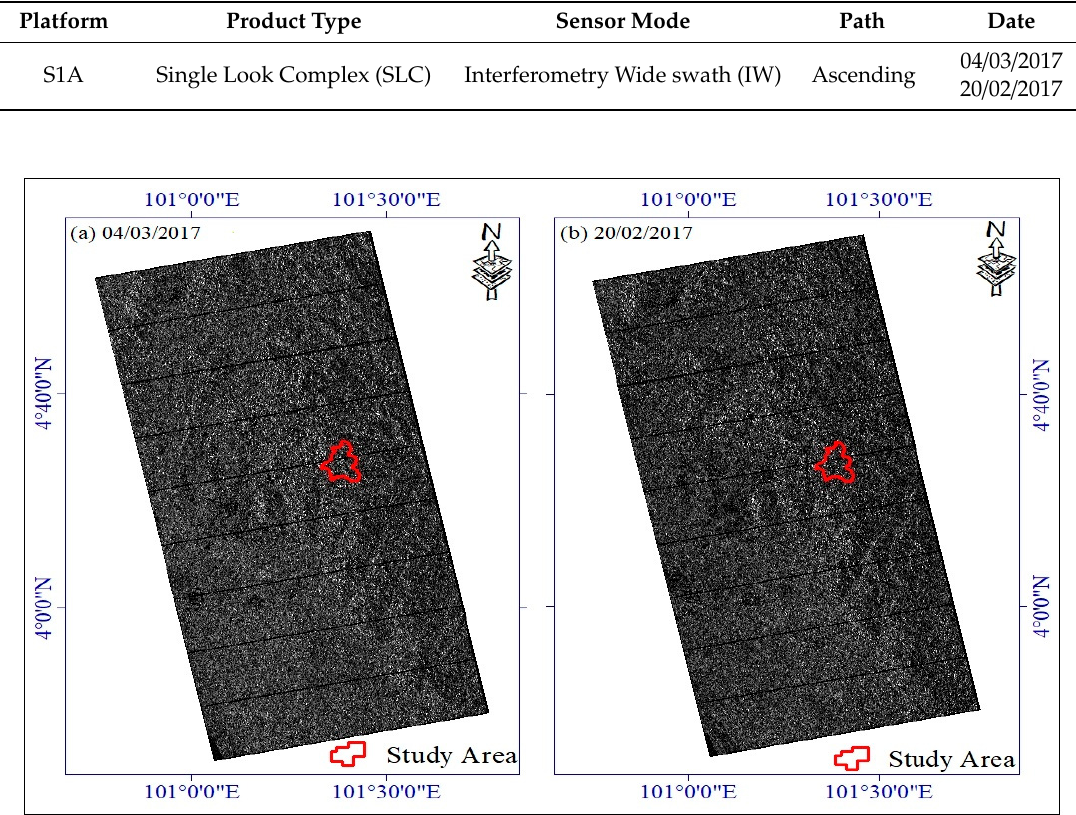
Figure 3. Sentinel-1 images and location of the study site.